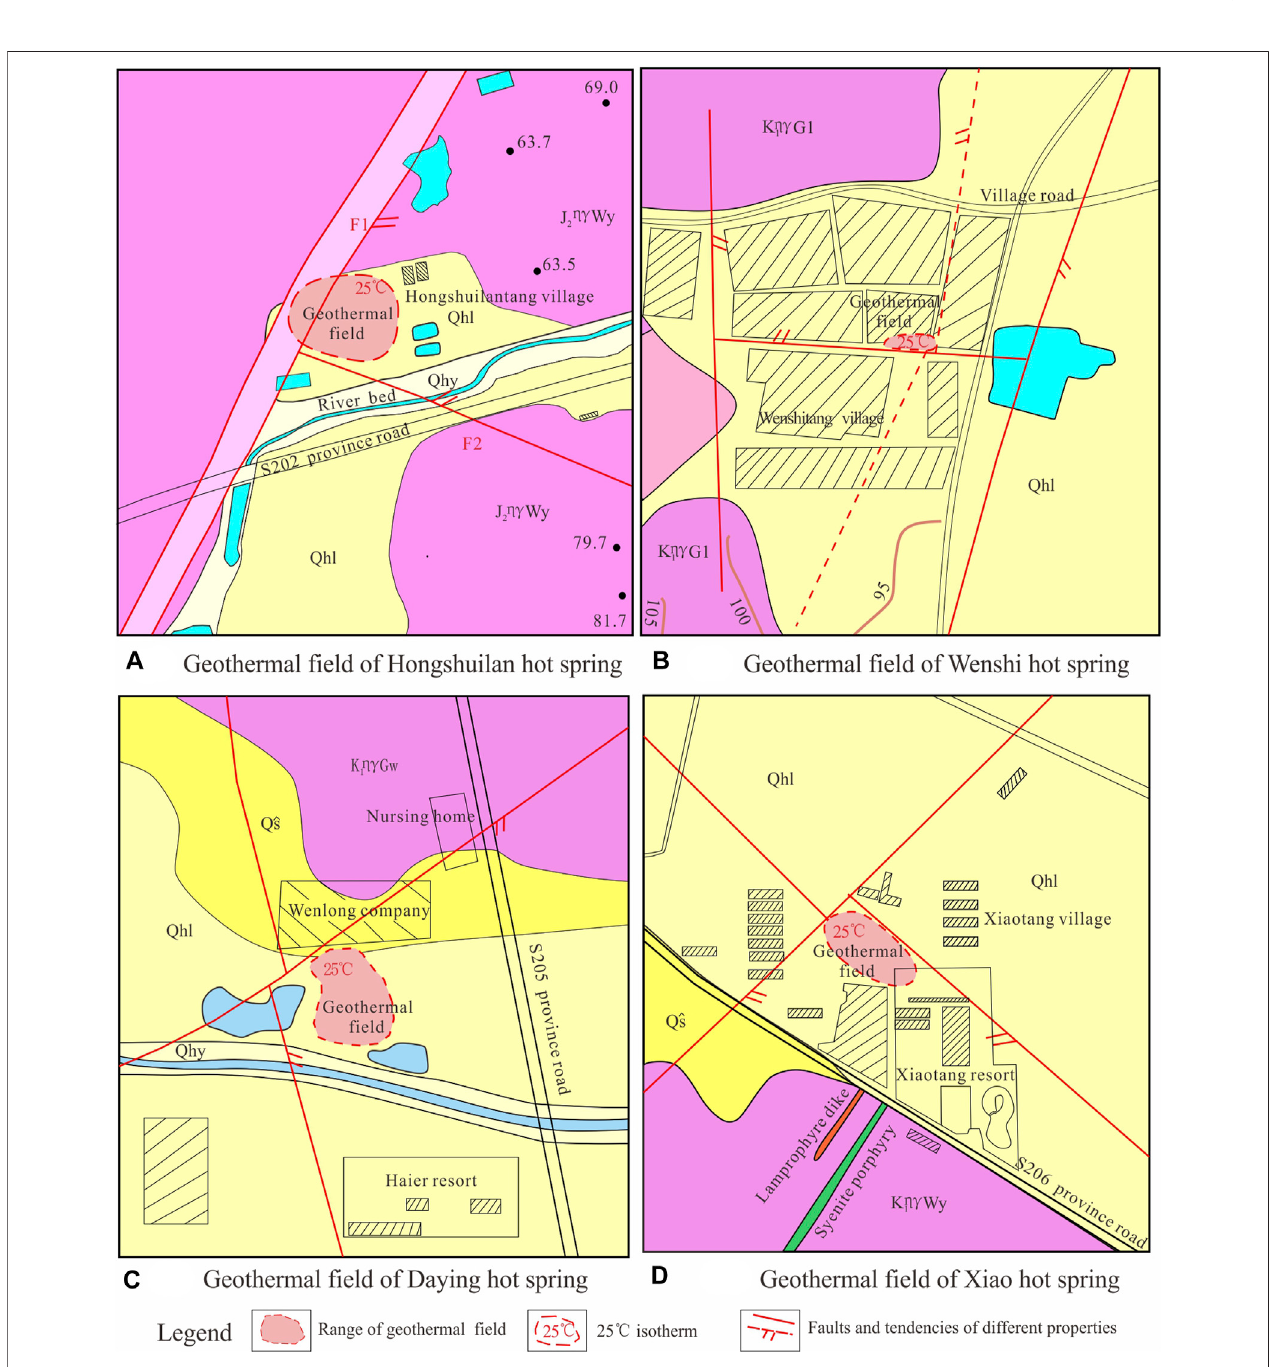
FIGURE 8 | Typical geothermal fi eld distribution in the Jiaodong Peninsula: (A) Hongshuilan, (B) Wenshi, (C) Daying, and (D) Xiao hot springs.